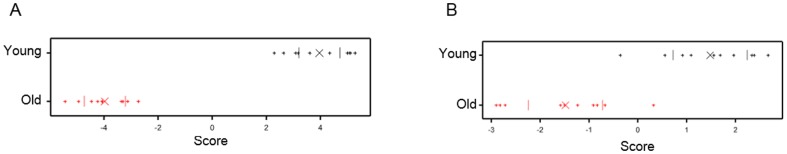
Graphical representation of the discriminant analysis.Two discriminant analysis models were used comprising of 9 miRNAs (A) and 4 miRNAs (B) selected with the smallest validation error. A. The first model correctly classified all subjects into their original age groups with old subjects (red) receiving negative scores and young subjects (black) receiving positive scores. B. The second model correctly classified 18 subjects into their original age groups and misclassified one old subject who received a positive score and one young subject who received a negative score. The mean for each group is represented by an X and standard deviation by vertical lines.